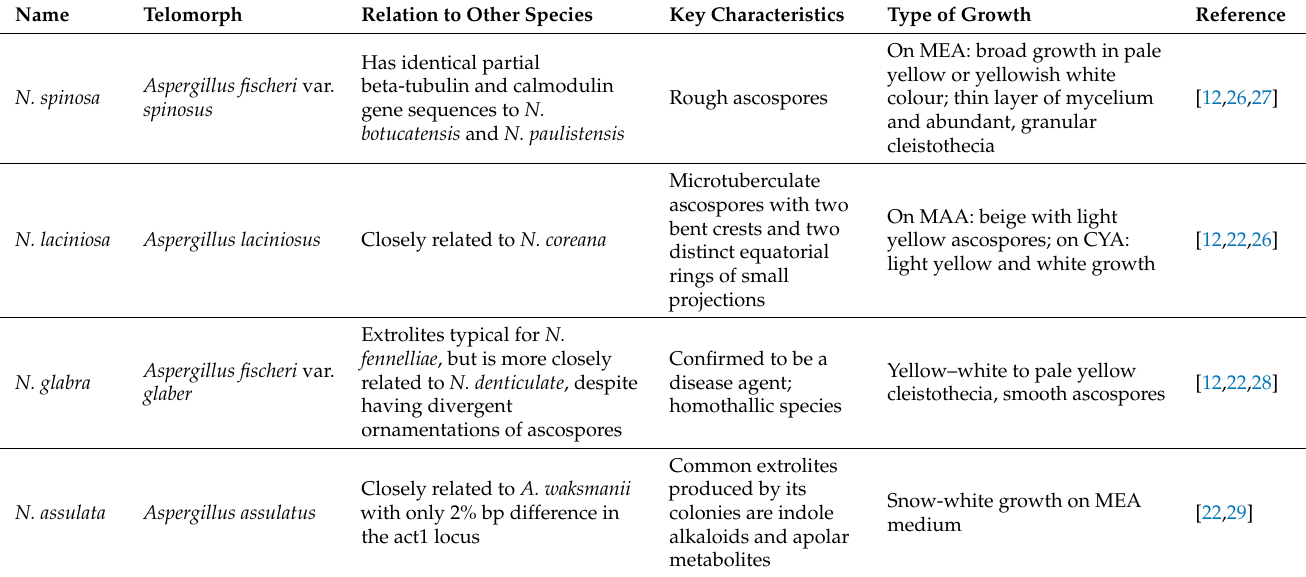
Table 2. Common Neosartorya spp. species and their